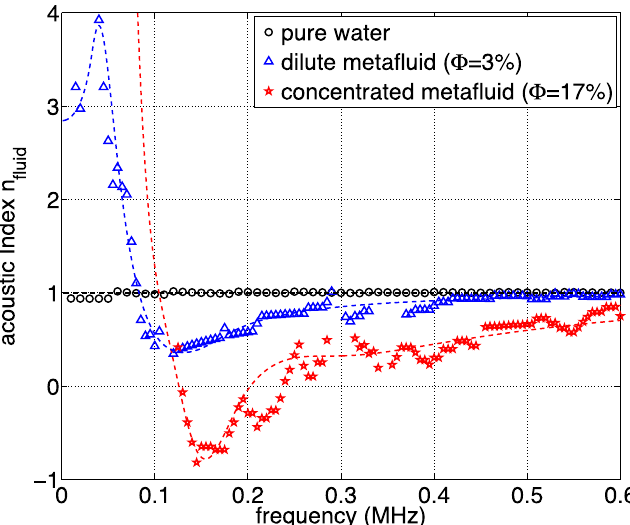
Figure 4. Acoustic index n fluid for different fluids confined in the prism-shaped box and extracted as a function of frequency from the k -maps. Dashed lines refer to calculations performed in the framework of multiple scattering theory (see the